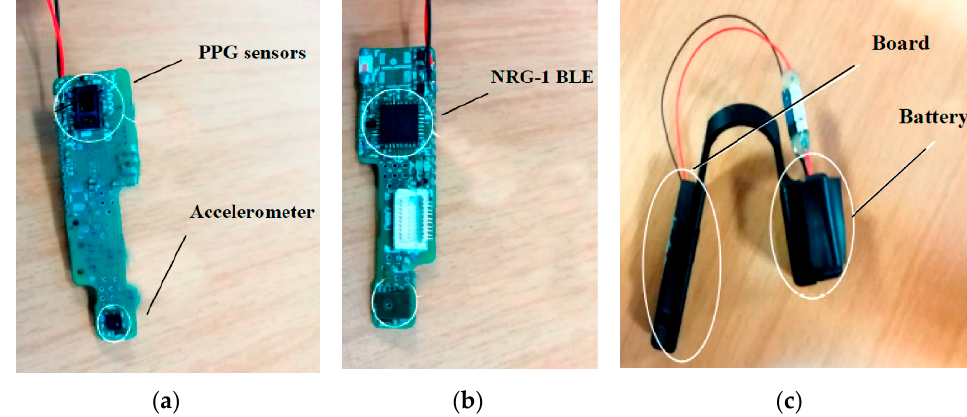
Figure 9. The external case of the MORFEA device ( a ), with the accelerometer and PPG sensors on one side ( b ), and the Bluetooth module on the other ( c ) [115].